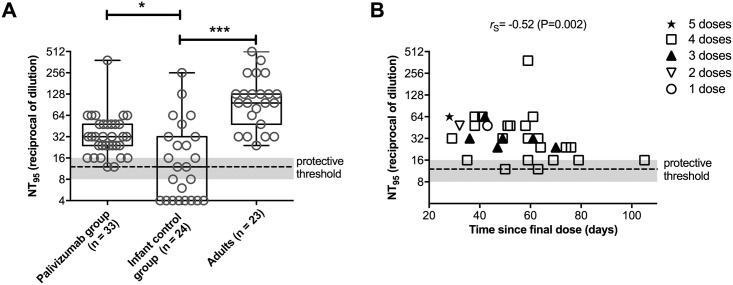
End-of-season anti-RSV NAb levels in at-risk infants who had received palivizumab prophylaxis in accordance with the BC RSV immunoprophylaxis program guidelines that were in effect during the 2013/14 and 2014/15 seasons (palivizumab group) and in control subjects.A, Comparison of anti-RSV NAb levels (expressed as neutralizing titers (NT95)) between infants of the palivizumab group and two control groups of infants ≤12 months of age and healthy adults who did not received palivizumab. B, Anti-RSV NAb levels in the palivizumab group plotted against the number of days since they had received the final dose of palivizumab. Dashed lines indicate the median NT95 (grey shaded area indicates min and max value) equivalent to 40 μg/ml palivizumab (defined as the minimum protective threshold). ***, P < 0.001; ****, P < 0.0001; rS, Spearman correlation coefficient.